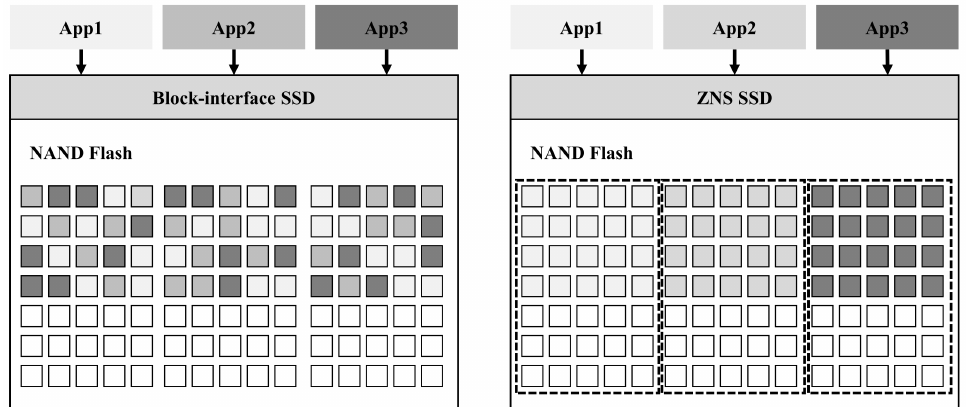
Figure 1. Comparison of a block-interface SSD and a ZNS SSD.